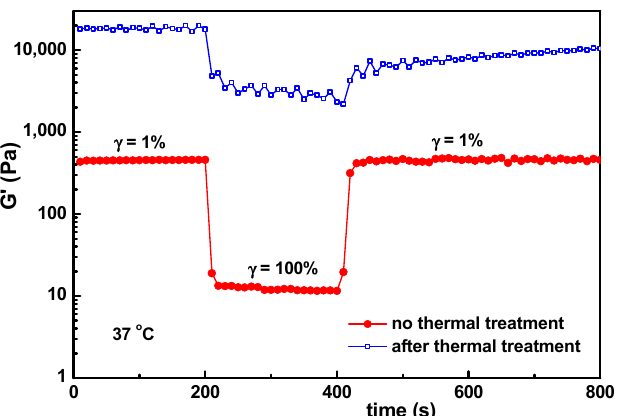
Figure 10. The influence of the thermal treatment (sample kept at 70 ◦ C for 1 h and then cooled to 37 ◦ C and thermostated for 1 h) on the self-healing behavior of the hydrogel with w BSA = 0.5. BSA contains 582 amino acid residues with 17 disulfide bonds and one free thiol group at residue Cysteine (Cys)-34; approximately 17% of the amino acid residues are basic or acidic, and 28% are hydrophilic [63]. The secondary structure of native BSA is composed of 50–67% α -helix, 10% turn and about 23% random coil (no β -sheet) [39]. Previously, Peter [64] reported the presence of 15–18% β -sheet in the native protein. The shape of